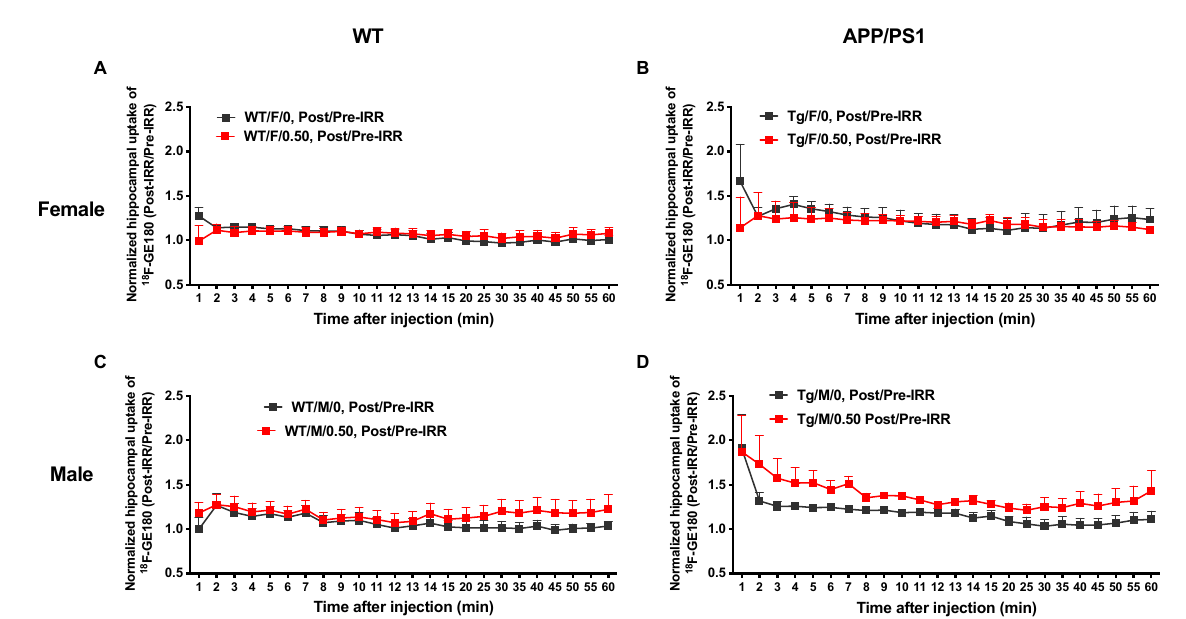
Figure 3. 56 Fe irradiation increased hippocampal neuroinflammation in male APP/PS1 mice. To investigate radiation-specific effects on neuroinflammation, we normalized post-irradiation 18 F-GE180 PET signal by its pre-irradiation 18 F-GE180 PET signal for each group (post-irradiation/pre-irradiation). 56 Fe irradiation did not increase neuroinflammation ( 18 F-GE180 uptake) in female mice ( A , B ) or in WT males ( C ). However, 0.50 Gy of 56 Fe significantly increased neuroinflammation in APP/PS1 males ( D ). n = 3–4 mice/group. Data were analyzed with a 2-way ANOVA followed by Bonferroni’s post hoc test.